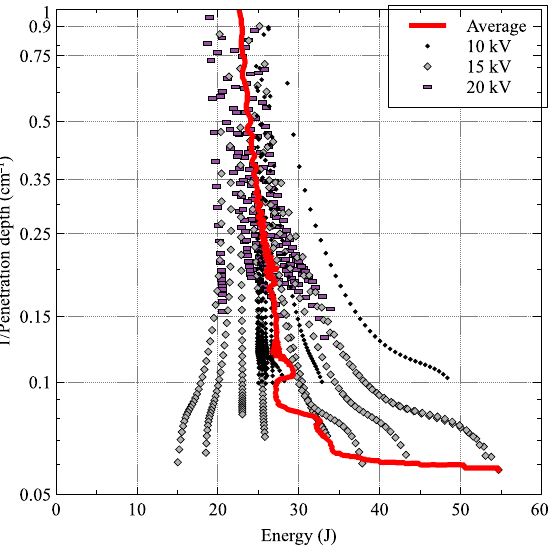
Figure 12. (Color online) iron metal gas penetration depth depending on the absorbing energy. As in the platinum case, the average of all the available data is